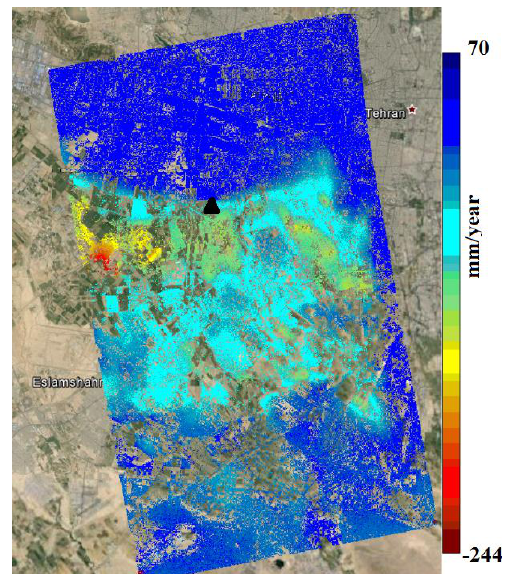
Figure 3. Mean velocity of subsidence obtained by using proposed approach in this paper. The black triangle shows the location of permanent GPS